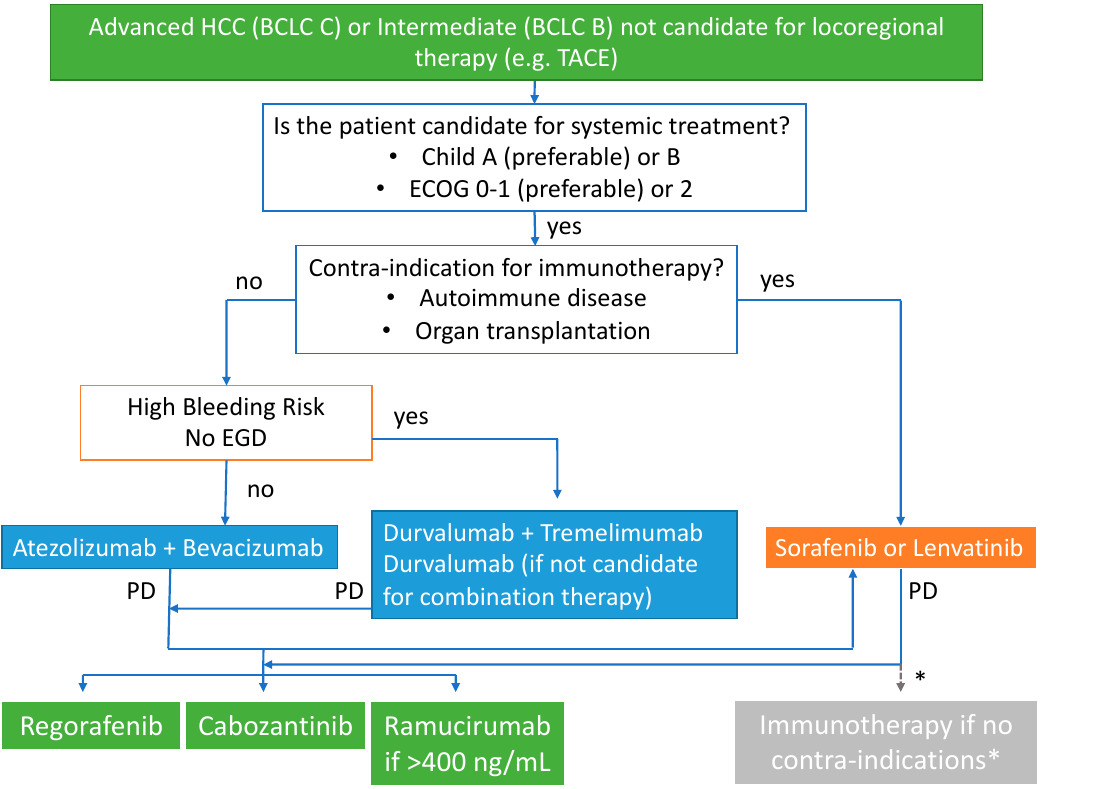
Figure 1. Proposed sequencing algorithm for advanced HCC.